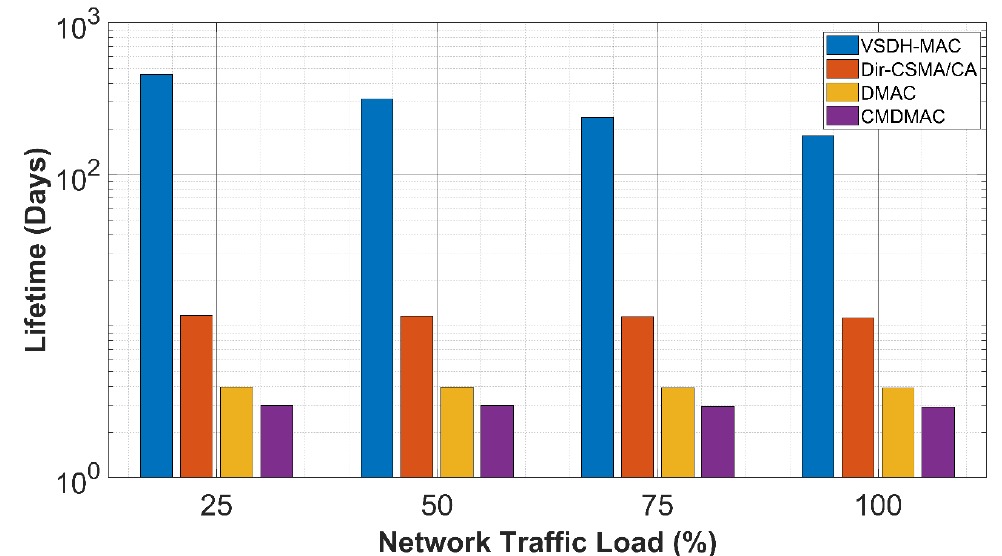
Figure 9. Comparison of expected sensor node lifetime with different network traffic load.